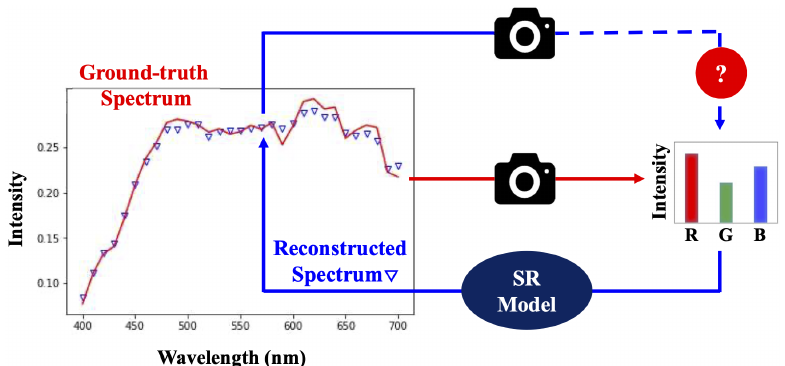
Figure 1. Our physical plausibility (color fidelity) test for SR.